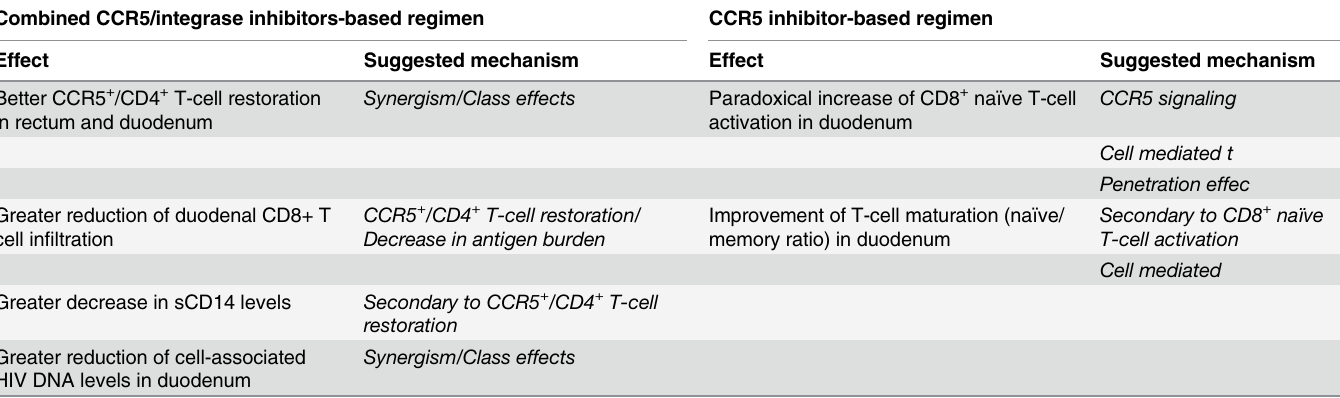
Table 2. Summary of the effects of combined CCR5/Integrase Inhibitors-based regimen vs. CCR5 inhibition on intestinal T cell